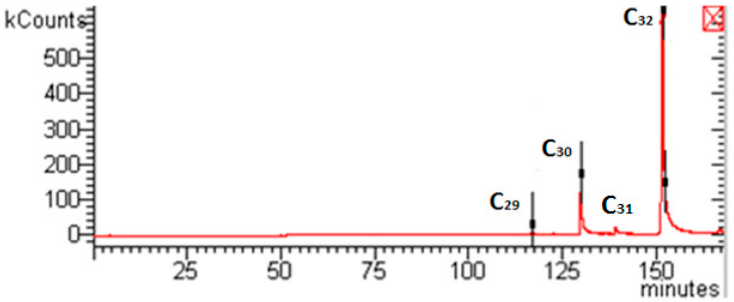
Figure 4. Example of a GC-MS trace related to waxes collected in the I separator at − 14 °C and 100 bar.